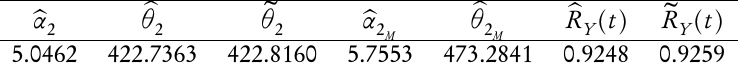
The MLE, UMVUE and Bayes estimator of parameters α corresponding reliability function R ( t ) for time t = 2 based on Data set II.